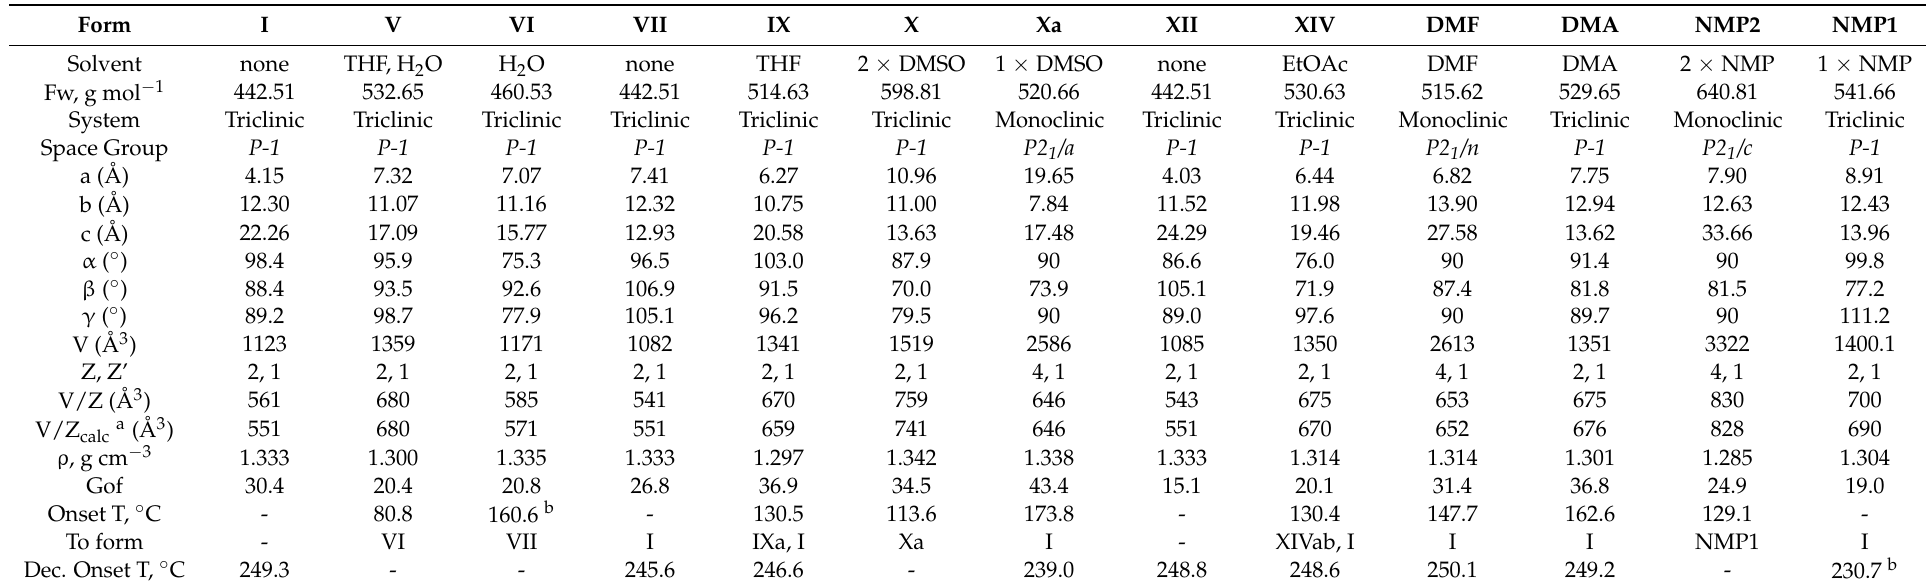
Table 16. Synoptic collection of crystal data for the different phases of